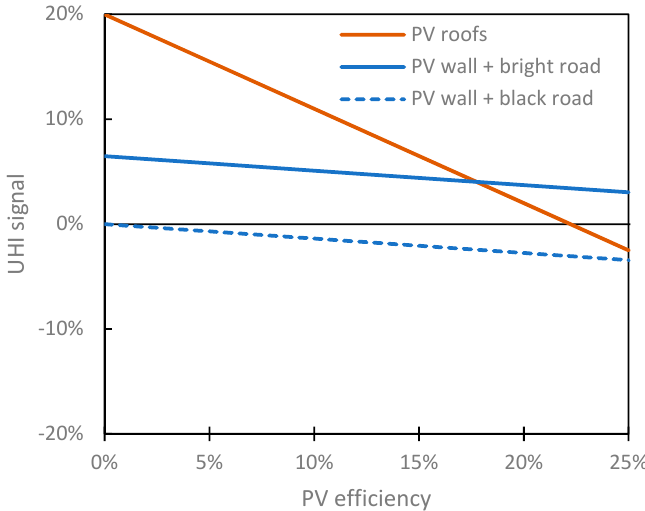
Figure 2. E ff ect of PV e ffi ciency (horizontal axis) on the relative irradiance balance, the UHI signal, for rooftops (red line) and facades (blue line). The solid line refers to a bright road and the dashed line refers to a dark road. Results for α r = 30%; α PV = 10%; α w = 70%; θ = 23; α g = 30% (bright road) or α g = 0% (dark road).